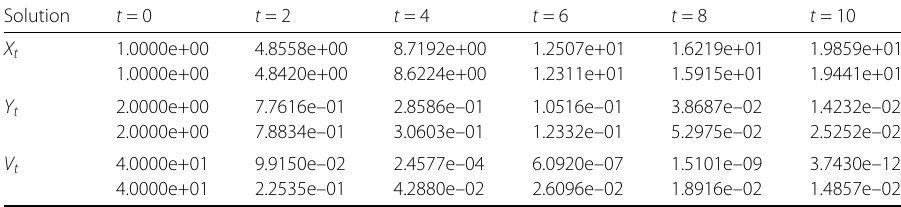
Table 2 Approximate solutions using RK4 (first row) and numerical technique (59) (second row, Ω = 0.99) with step-size h = 10 –3 over [0,10] for X (0) = 1, Y (0) = 2, V (0) = 40 having parameter k = 0